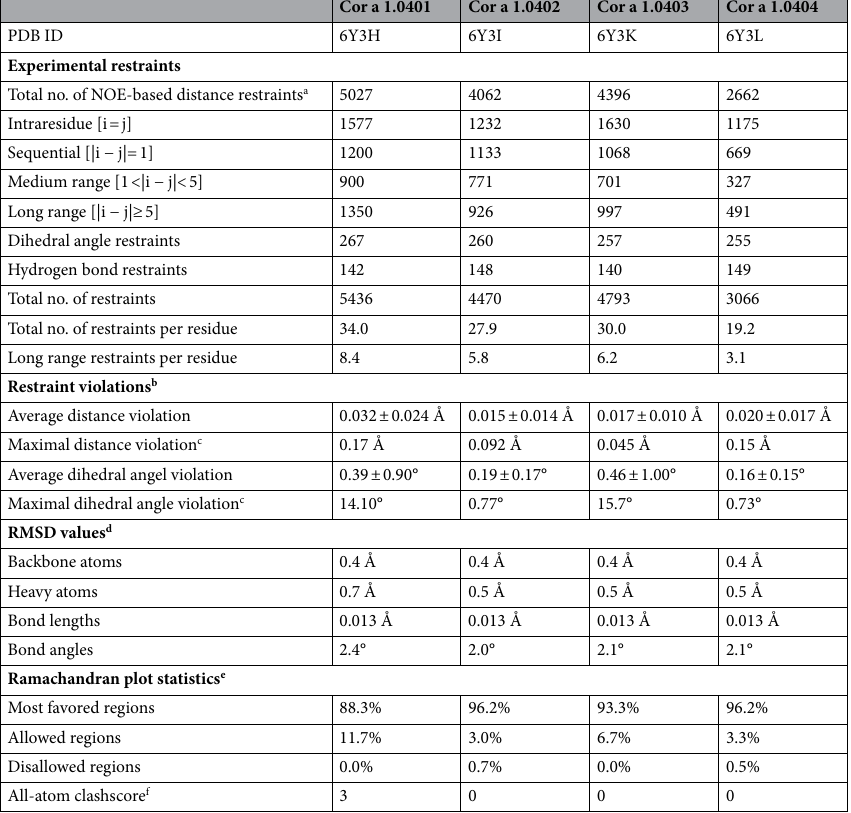
Table 1. Statistics and summary of structure determination and refinement. a Numbers are given for all residues (Gly1–Cys160). b Calculated for all residues as sum over r −6 . c Largest violation among the 20 lowest energy structures. d Pairwise RMSD was calculated among the 20 lowest energy structures. e Obtained with the protein structure validation software (PSVS) suite 61 . f All-atom clashscore, defined as number of overlaps (≥ 0.4 Å) per 1000